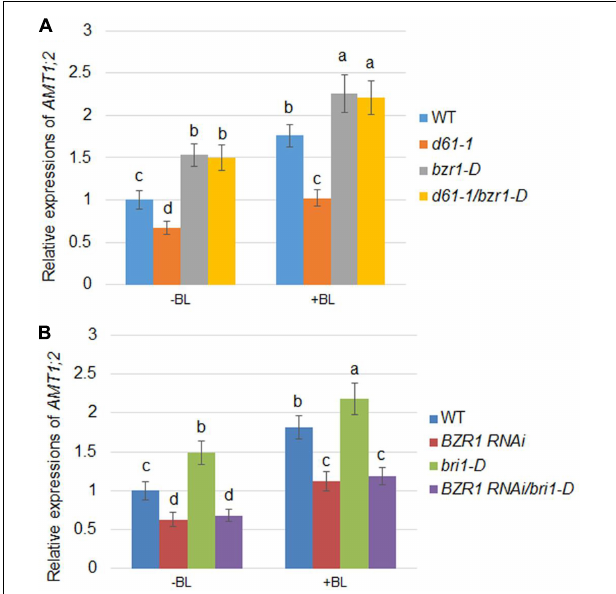
FIGURE 6 | NH 4 + -induced AMT1;2 expression in BZR1 , BRI1 , and their genetic combinations. (A) NH 4 + -induced AMT1;2 expression was detected in the wild-type, BRI1 mutant d61-1 , gain-of-function mutant bzr1-D , and their cross offspring d61-1 / bzr1-D . (B) NH 4 + -induced AMT1;2 expression was detected in BZR1 RNAi , BRI1 overexpression line bri1-D , and their cross offspring BZR1 RNAi / bri1-D . Full root sampling was carried out on 17-day-old seedlings that were transferred to nutrient solution containing 0.5 mM (NH 4 ) 2 SO 4 for 0 and 3 h. Measurement of AMT1;2 expression levels using qRT-PCR. Sample mRNA levels were normalized with respect to those of Ubiquitin . Data represent means ± SE ( n = 3). The experiments were repeated at least three times. Different letters represent statistically significant differences ( P <